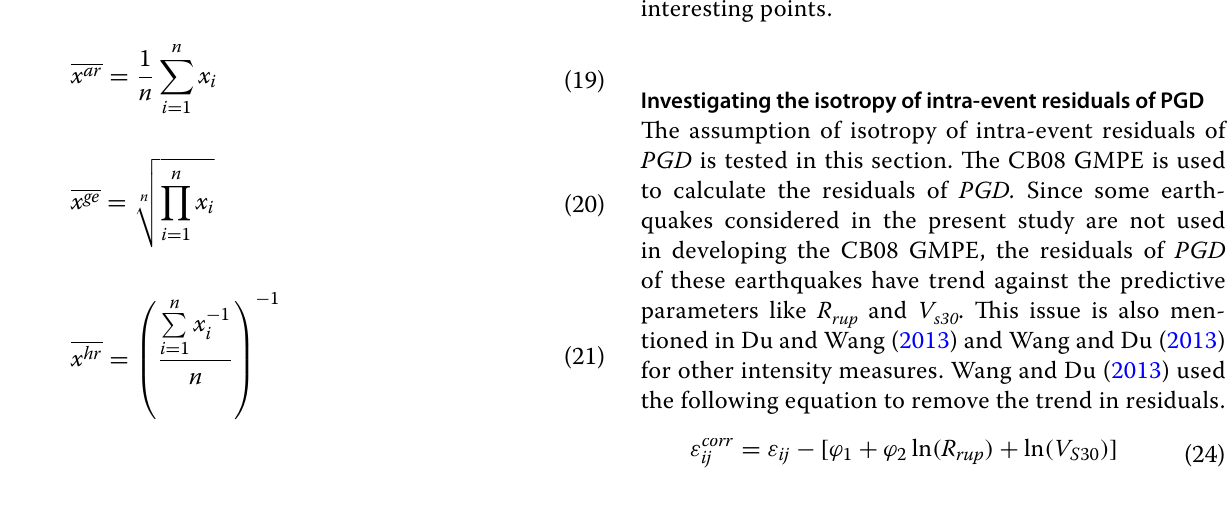
-PGV and the different definition of average source-to-site distance max